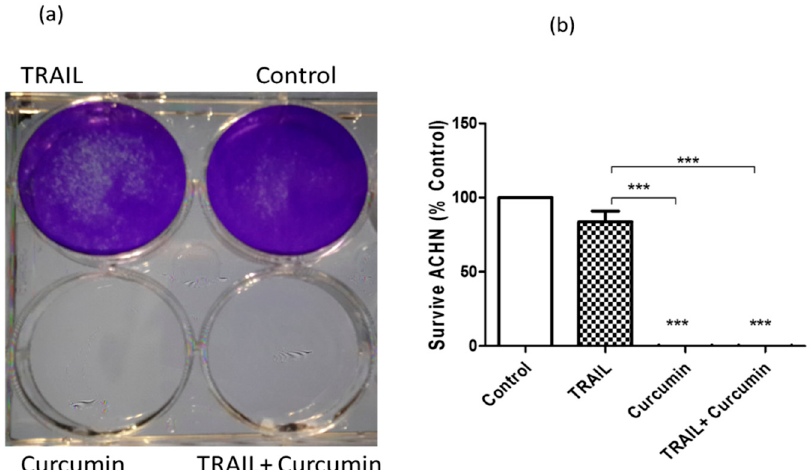
Figure 2. Effect of curcumin on the long-term survival of cancerous ACHN cells. Cells were treated either with 25 µM curcumin, 25 ng/mL TRAIL or a combination of both, then stained five days post treatment with 0.1% crystal violet. ( a ) Photographic image of the plate: clear or colorless wells indicates no cells while purple stain refers to the presence of cellular growth. ( b ) Absorption intensity of crystal violet was measured spectrophotometrically and results are expressed as relative survival growth (% of control) ± standard error of the mean (SEM) of five independent experiments. *** indicate statistically significant difference at p < 0.001 compared to DMSO or TRAIL-treated cells. Data were analysed using ONE-WAY analysis of variance